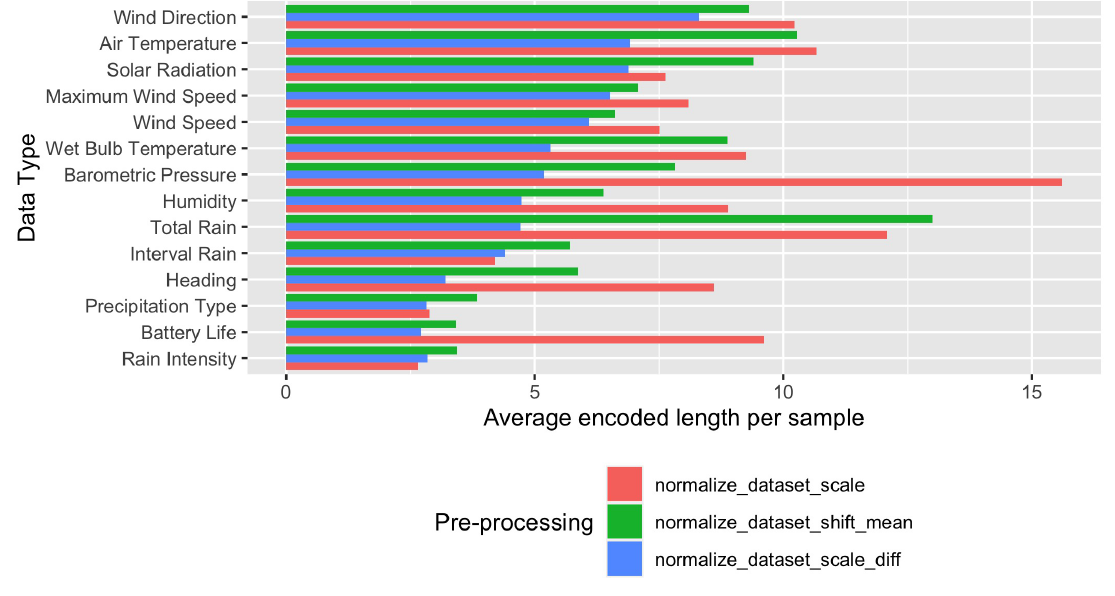
Figure 3. Estimation of the minimum bit-length after Rice